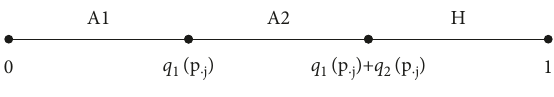
Figure 3: Customer choice behaviour